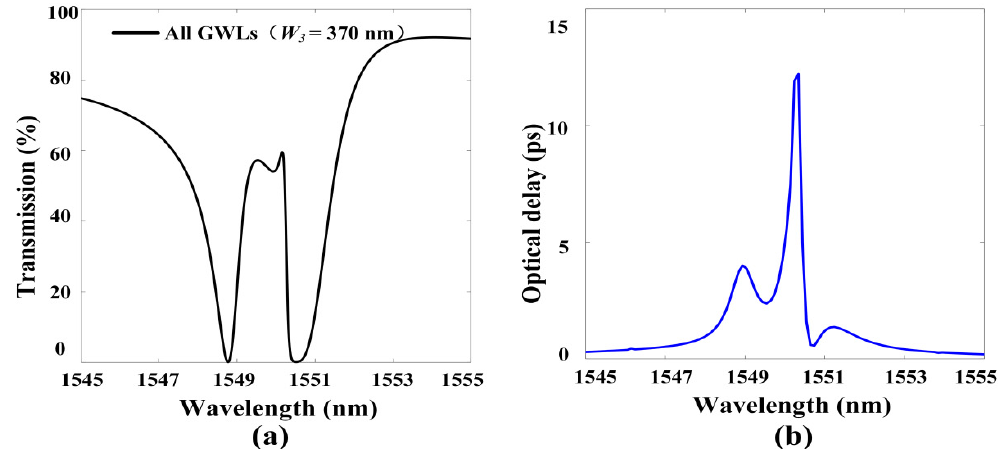
Figure 6. ( a ) Transmission spectrum of a wide-band flat-top transparent window, where the structural parameters are W 1 = W 2 = 400 nm, W 3 = 370 nm; other parameters are the same as those in Figure 1; ( b ) The delay time spectrum corresponding to the wide-band flat-top transparent window.